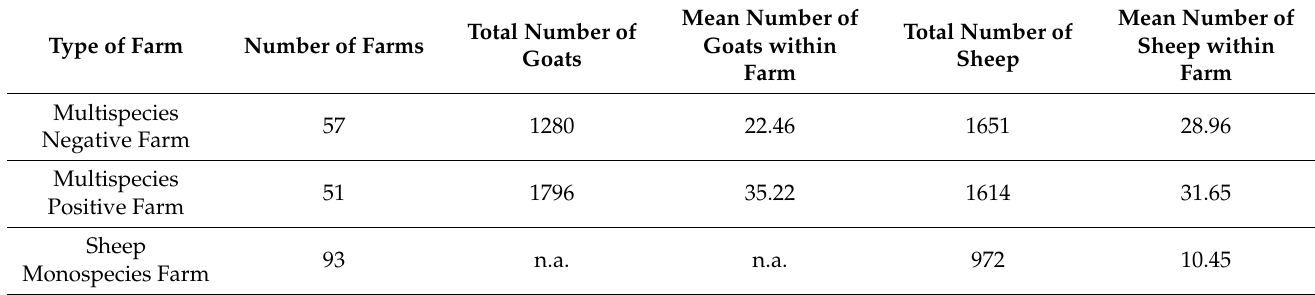
Table 1. Descriptive statistics of the studied